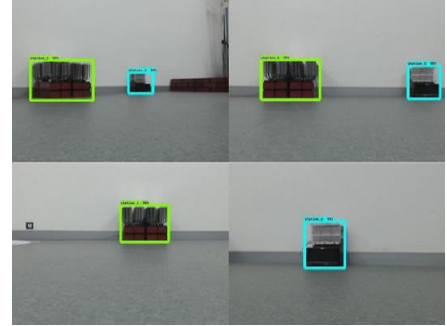
Energies 2019 , 12 , x FOR PEER REVIEW